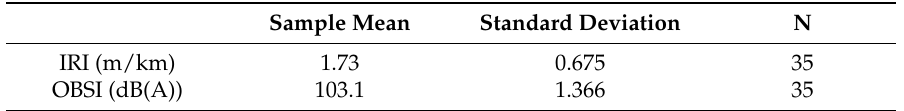
Table 2. Statistical description of international roughness index (IRI) and On-Board Sound Intensity System (OBSI).